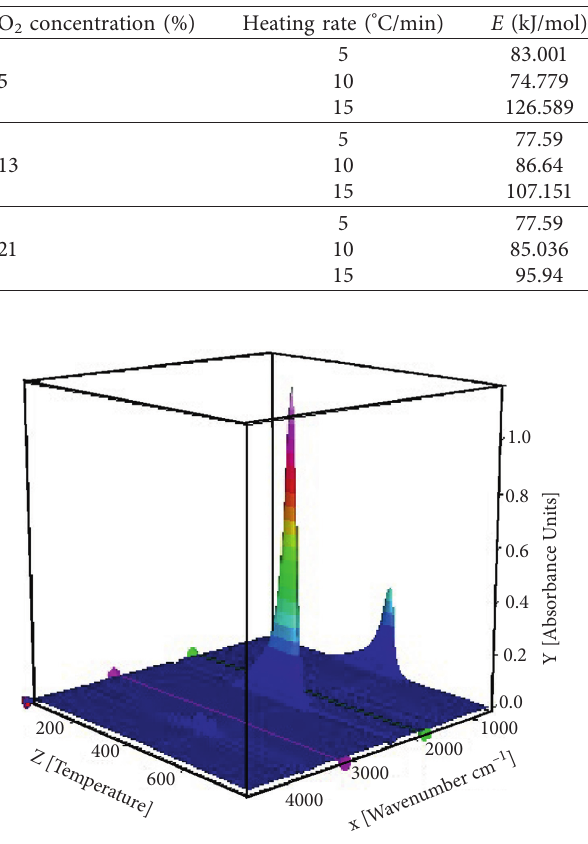
Figure 9: FTIR spectrum of gas products for the Bulianta 12# raw coal sample (air, heating rate � 10 °